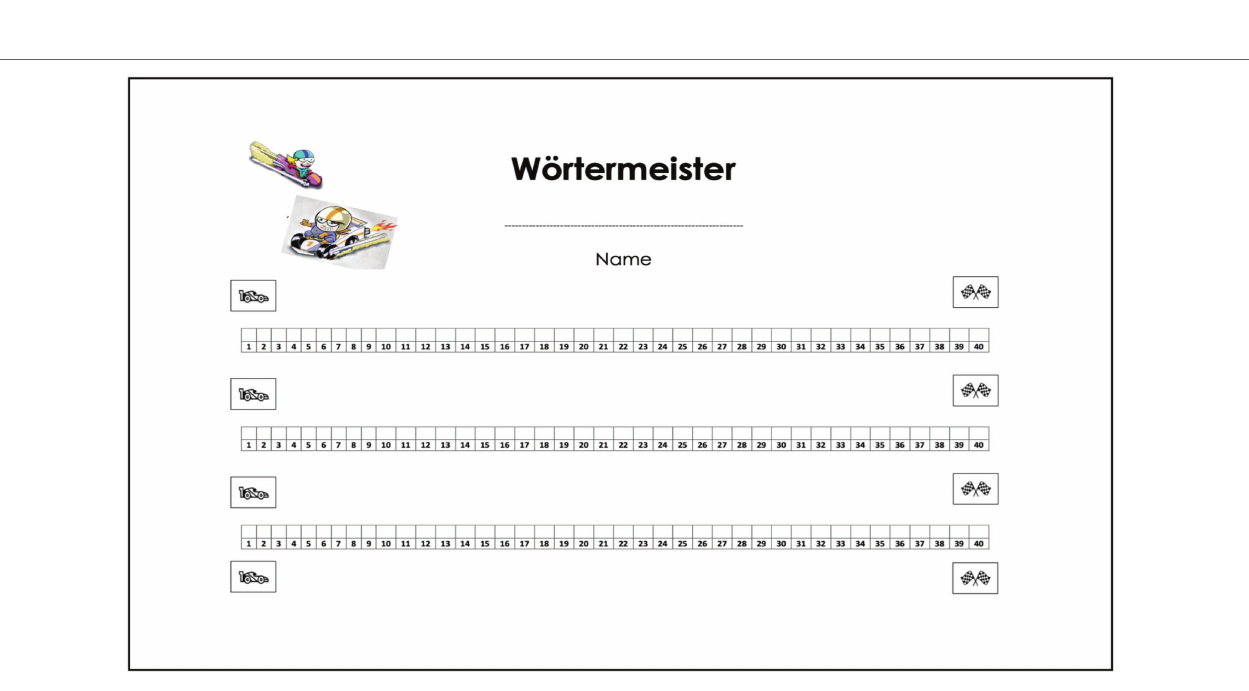
FIGURE 2 | Example of self-graphing sheet. Wörtermeister = word master.